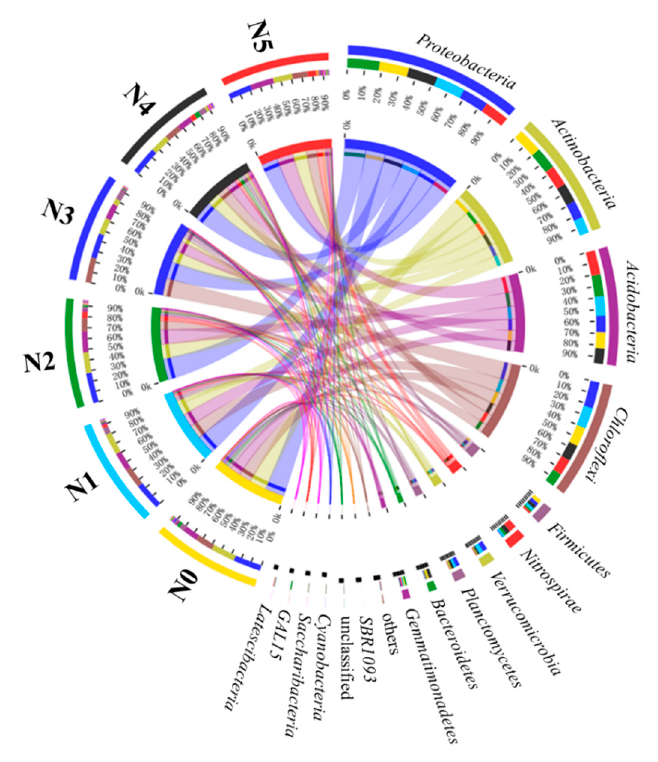
Figure 3. The relative abundance of 15 major bacterial phyla in the different nitrogen fertilization